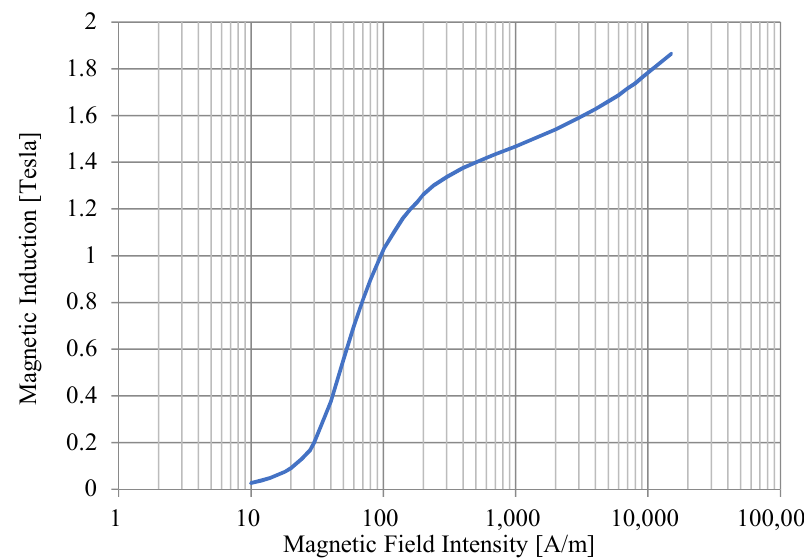
Figure 15. BH curve of 20PNF1500.